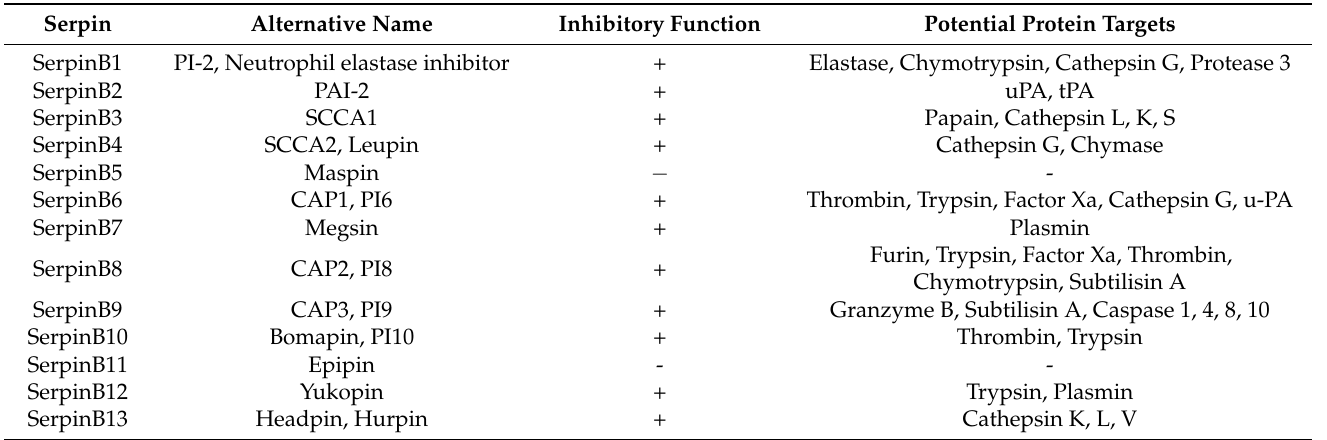
Table 1. Inhibitory function and targets of human clade B